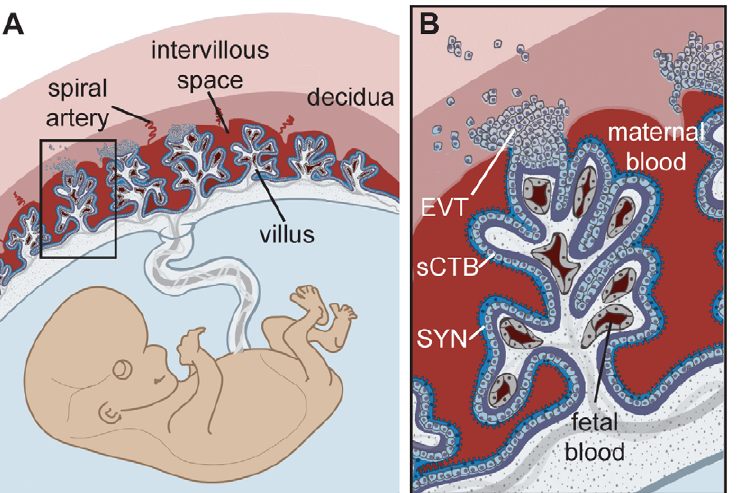
Figure 1. Human placental structure. ( A ) Structure and orientation of fetus and placenta in uterus. The uterine lining transforms into decidua. Maternal blood circulates freely in the intervillous space that contains numerous villous trees that are fetal in origin. ( B ) Enlargement of box in panel A. Maternal blood bathes the villous trees, which are covered by syncytium (SYN) that is underlaid by a population of progenitor cells called subsyncytial cytotrophoblasts (sCTB) and a basement membrane (purple). Fetal capillaries are located in the villous stroma. Exchange of gas and nutrients between maternal and fetal blood occurs across the syncytium. Cytotrophoblasts that come in contact with the decidua differentiate along the invasive pathway into extravillous trophoblasts (EVT). EVT anchor the placenta in the uterus and invade uterine vessels (not shown) to allow maternal blood to flow into the intervillous space.